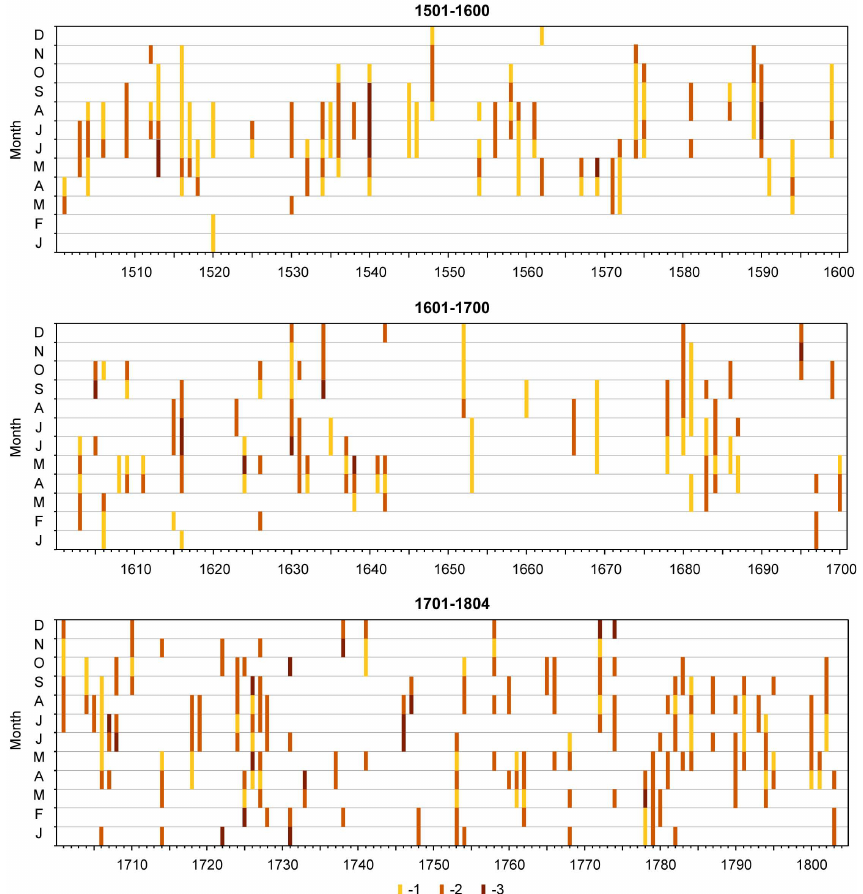
Fig. 3. Dry months/droughts in the Czech Lands interpreted from documentary evidence for the 1501–1804 period, with expression of their intensity by precipitation indices: − 1 dry month, − 2 very dry month, − 3 extremely dry